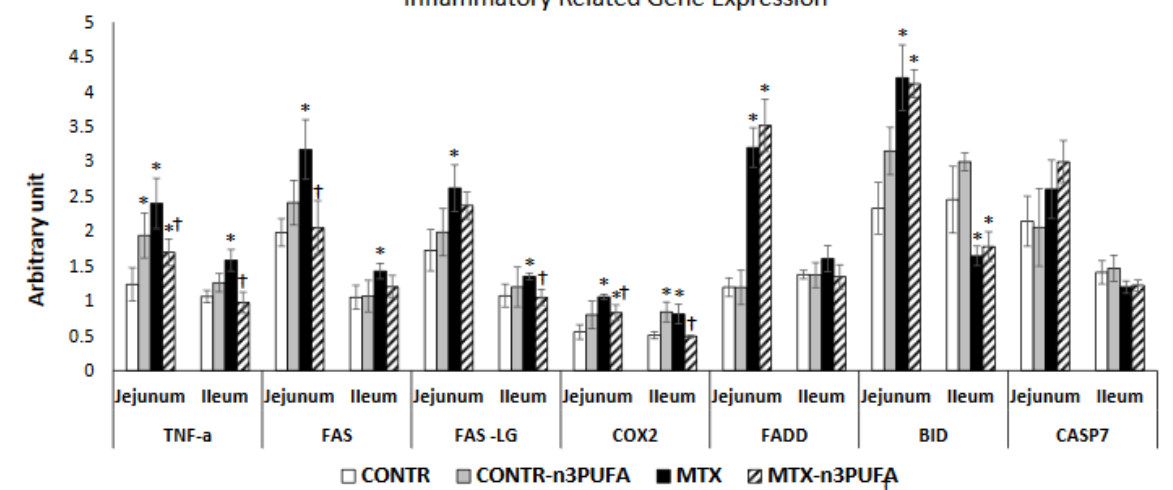
Figure 2. Effects of MTX and n-3 PUFAs on pro-inflammatory and apoptosis related gene expression. Real Time PCR was used to investigate gene expression. Relative changes in gene expression were normalized to housekeeping genes GAPDH and Tubulin. Values are mean ± SEM. CONTR-control, MTX-methotrexate, n-3 PUFAs- n-3 polyunsaturated fatty acids. * p < 0.05 all groups vs. CONTR rats, † p < 0.05 MTX-n-3 PUFAs vs. MTX rats.